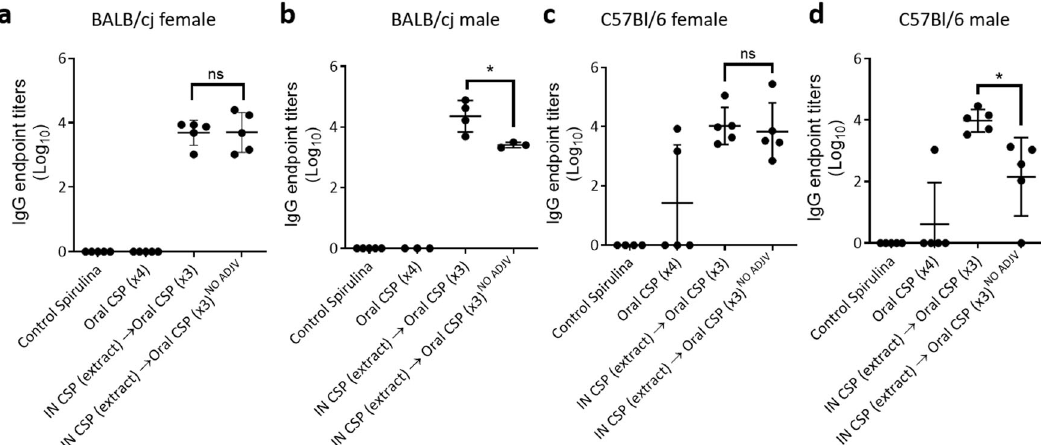
Fig. 3 Immunogenicity in male and female mice with and without Montanide adjuvant. PfCSP ELISA titers in female BALB/cJ mice ( a ), male BALB/cJ mice ( b ), female C57Bl/6J mice ( c ), and male C57BL/6J mice ( d ) immunized as in Fig. 2 and assessed at the time of challenge (Day 70). p > 0.05 (ANOVA with post-hoc Tukey test for multiple comparisons).